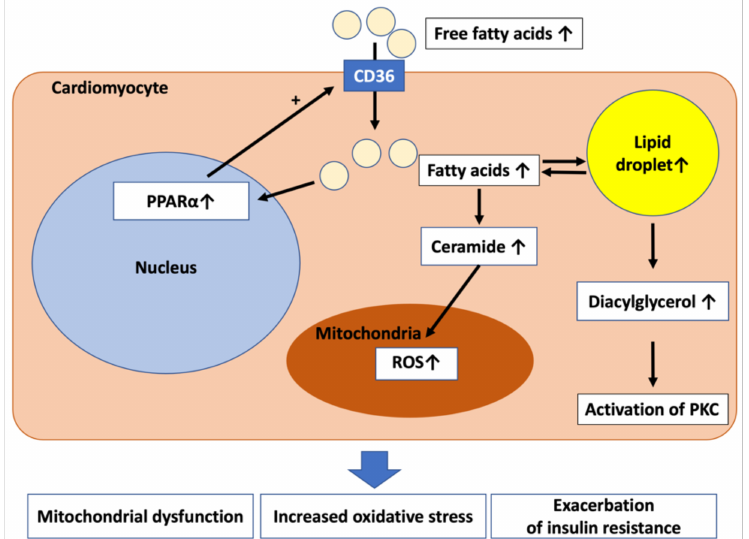
Figure 1. Lipotoxicity to the myocardium in diabetic cardiomyopathy. CD36, cluster of differentiation 36; PKC, protein kinase C; PPAR α , peroxisome proliferator-activated receptor α ; ROS, reactive oxygen